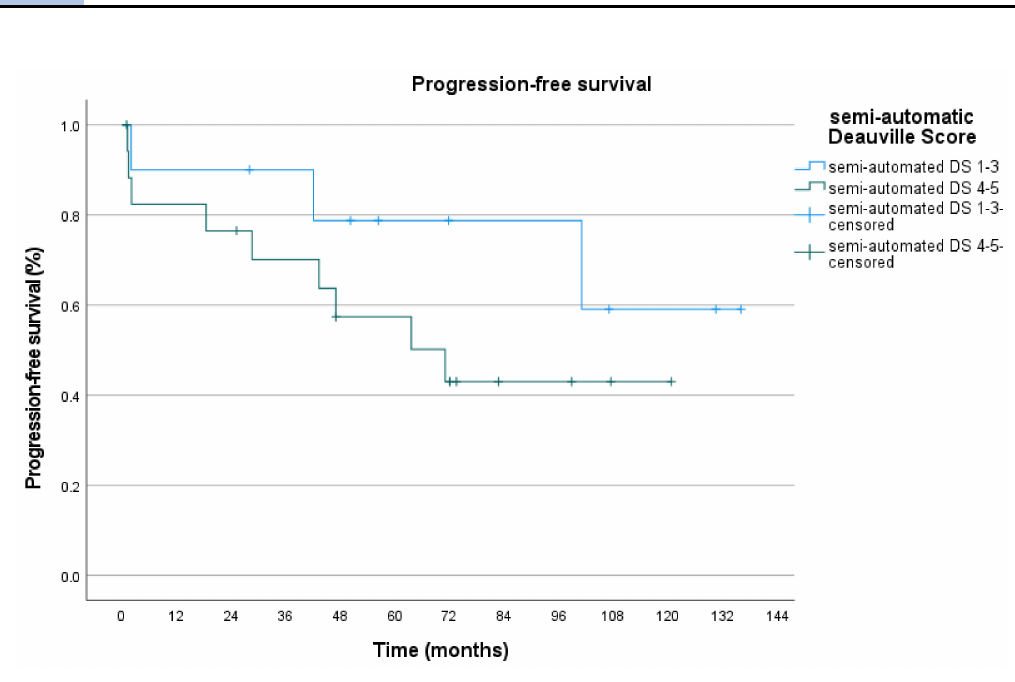
Figure 6. PFS for semi-automatic DS. Table 8. Number at